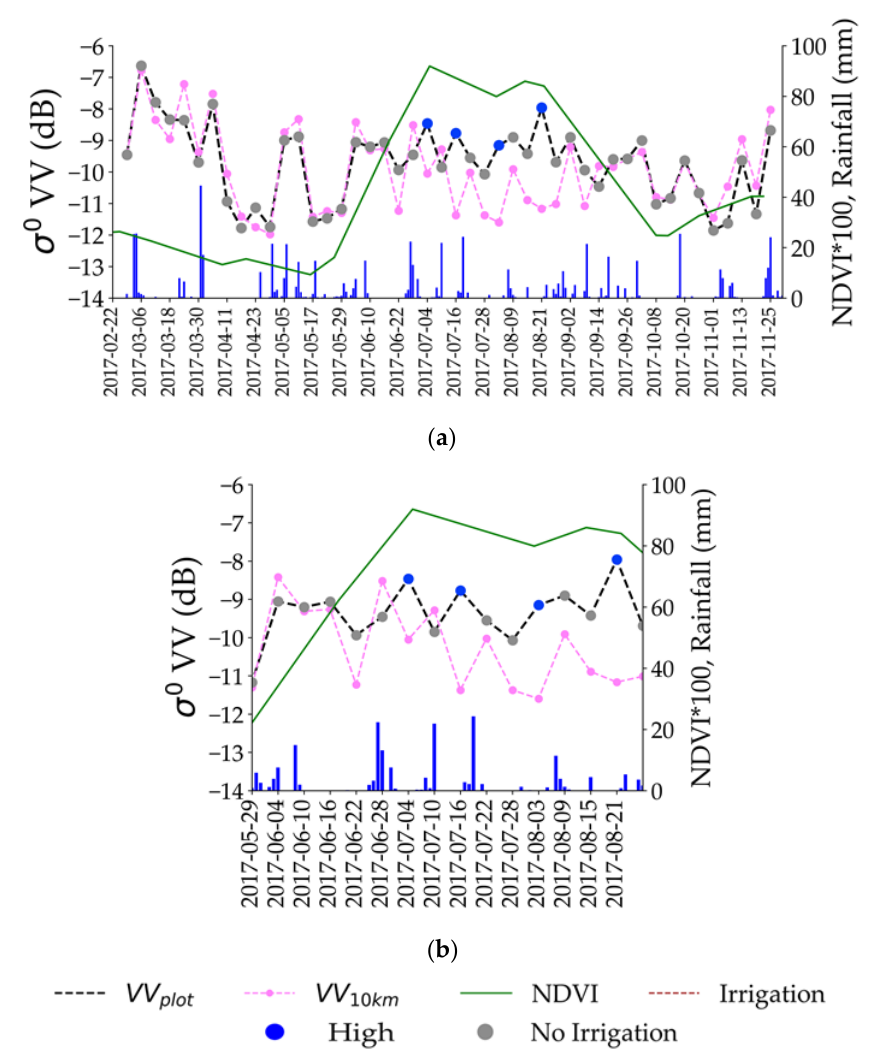
Figure 11. Irrigation events detection over a reference irrigated maize plot in Tarbes, France. ( a ) Complete temporal series between March and November 2017; ( b ) irrigation events detected between 29 May and 21 August 2017.